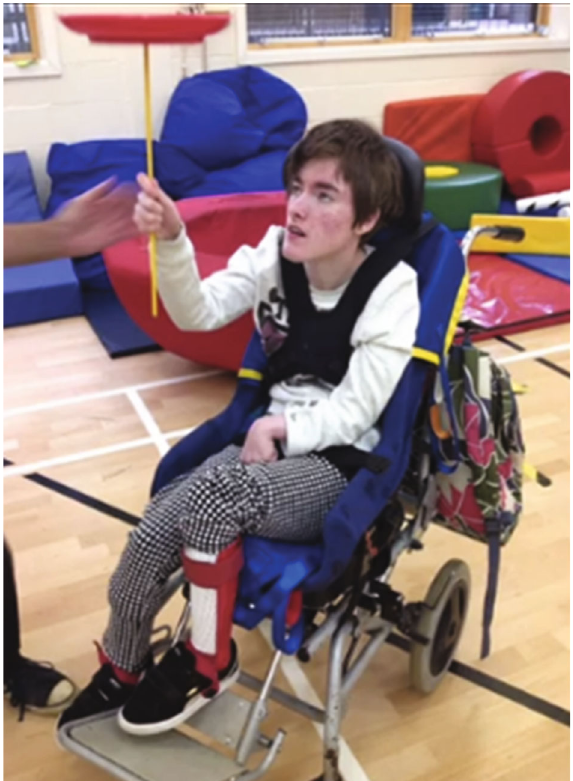
Figure 3: Participant focusing and spinning plates independently [35].